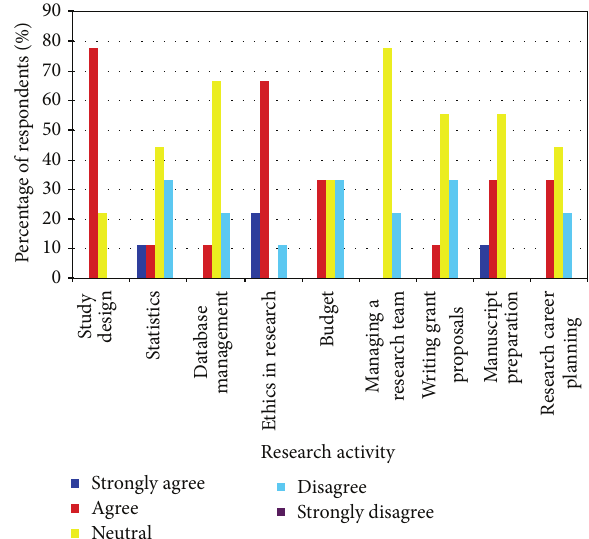
Figure3:Juniorfacultymembers’responsetothequestion:“Formal Figure 4: Response by program directors to the survey question: “I believe that graduates of our fellowship are comfortable with performing the following research activities.”